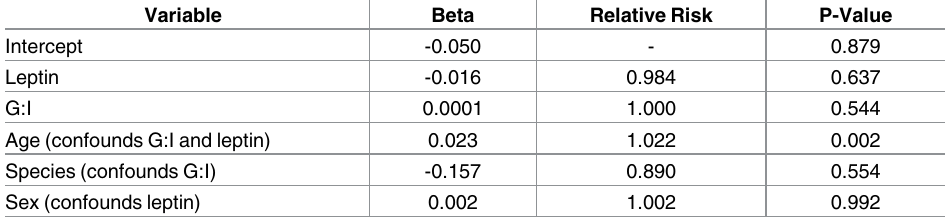
Table 6. Leptin and the glucose-to-insulin ratio (G:I) in predicting foot health using Poisson regression.